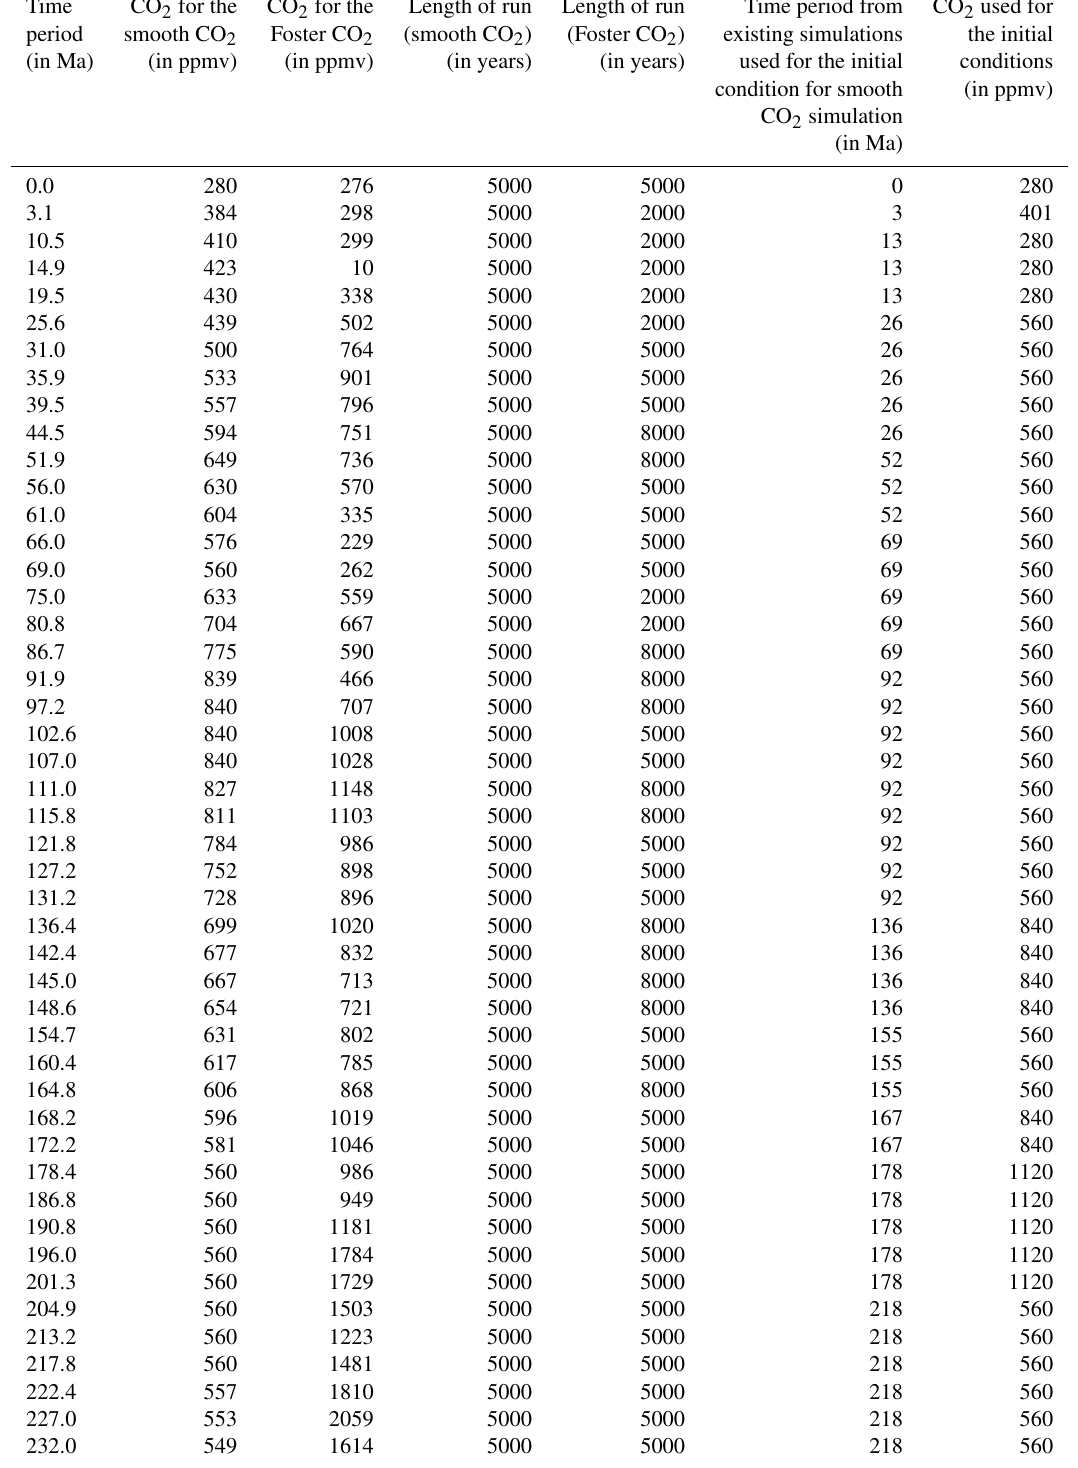
Table 2. Summary of model simulations. The table summarizes the simulations performed in this study. The sixth and seventh columns refer to how the model was initialized. The smooth CO 2 simulations were initialized from existing simulations using paleogeographies which were provided commercial in confidence. The time periods that these paleogeographies correspond to are listed in column 6, and the CO 2 value used in the runs is in column 7. The Foster CO 2 simulations were initialized from the end point of the smooth CO 2